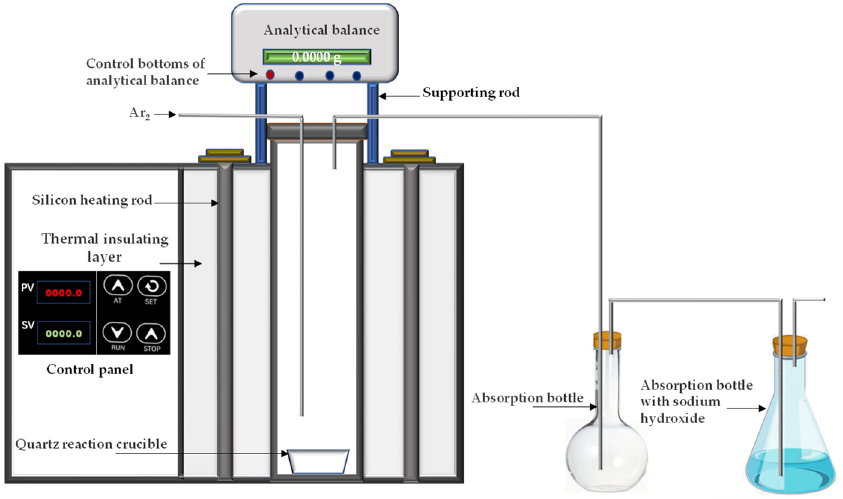
Figure 3. Experimental device.